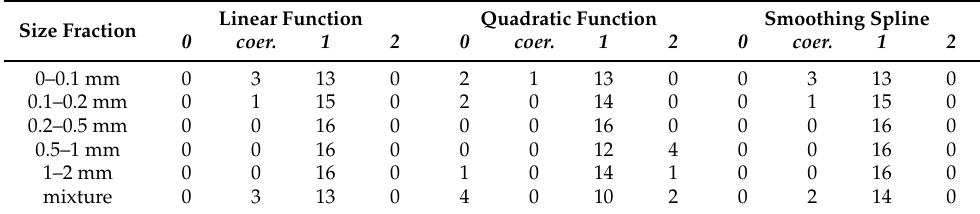
Table 2. Number of cases (out of total 16 images per size fraction) when the inverse model tested in leave-one-out manner returned: no outputs at all ( 0 ); only some out-of-range outputs which